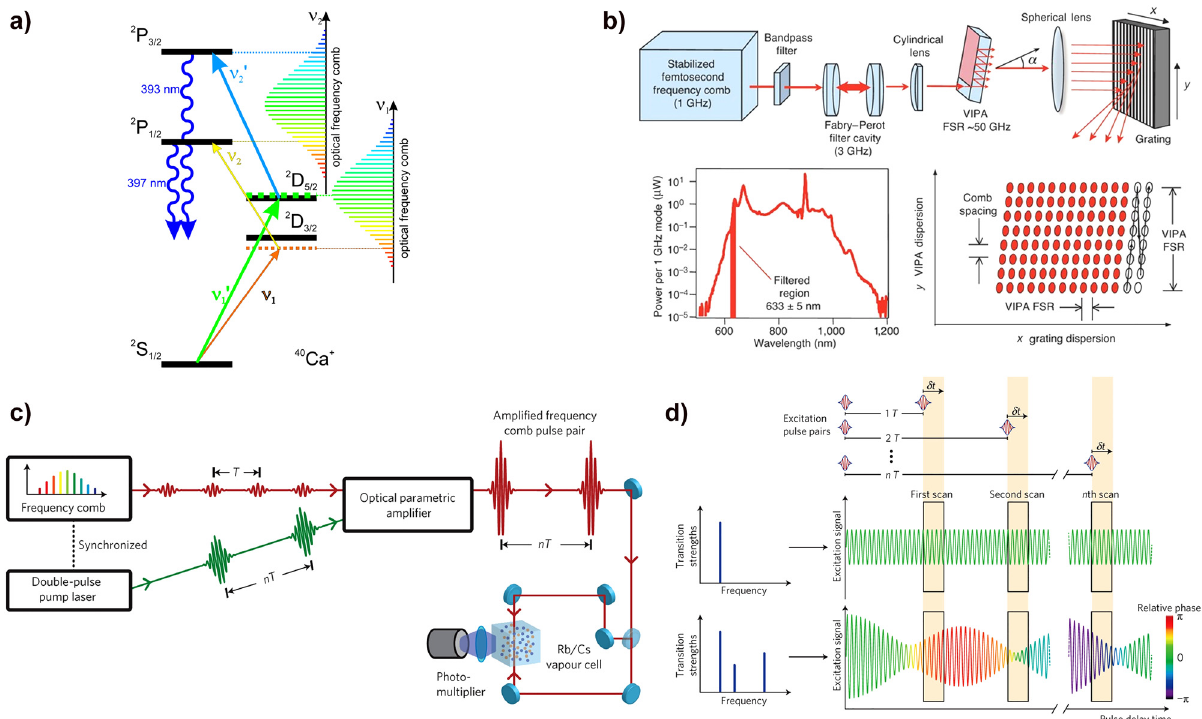
Figure 19: Basic types of optical frequency comb spectroscopy. (a) Direct frequency comb spectroscopy. An optical frequency comb incidents on the targets and some optical modes are absorbed by the excitationofthetargetatomsormolecules[241].(b)DispersivespectroscopyusingapairofVIPAandagrating.Theresultantcanbeexpressed as a dot array that depends on both the comb spacing and VIPA FSR [242]. (c) and (d) Ramsey-comb spectroscopy. (c) Experimental setup of